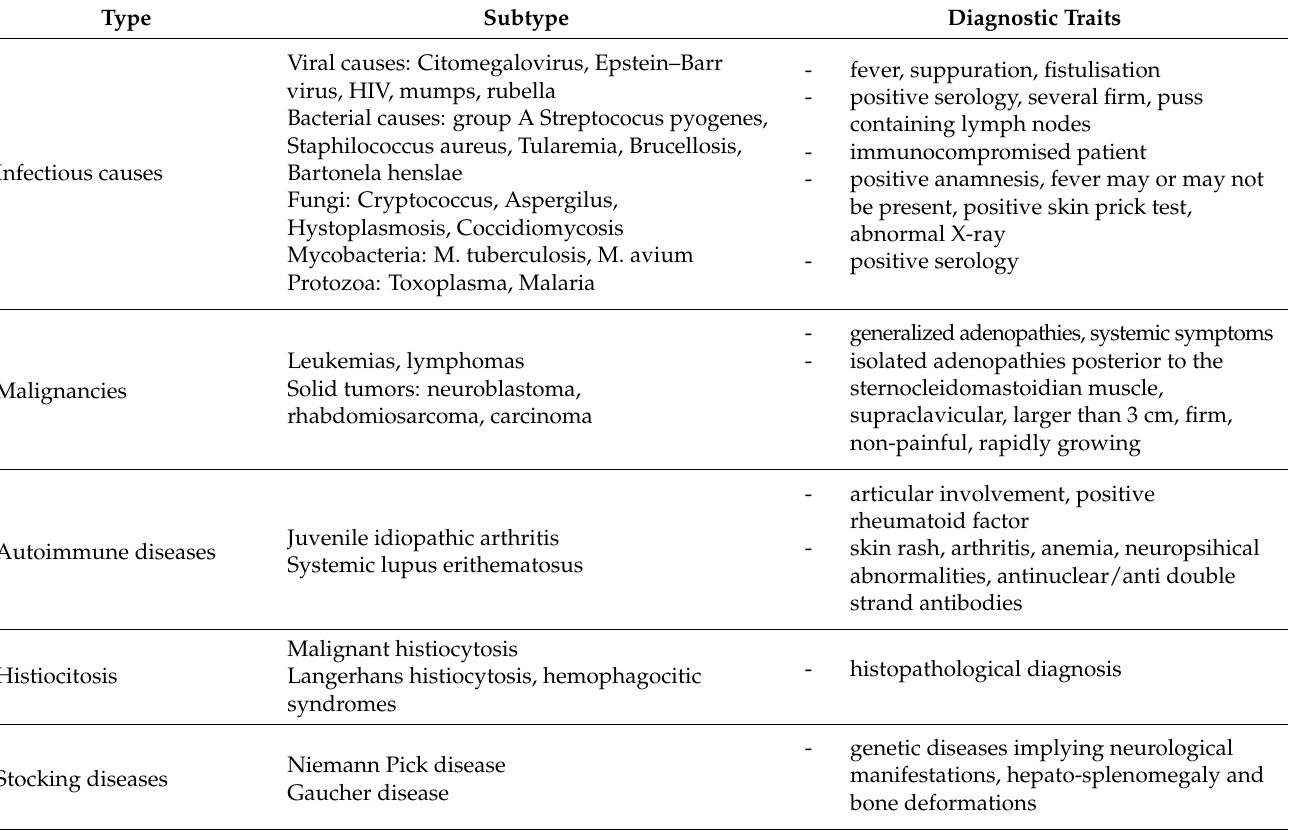
Table 1. Adenopathy causes in